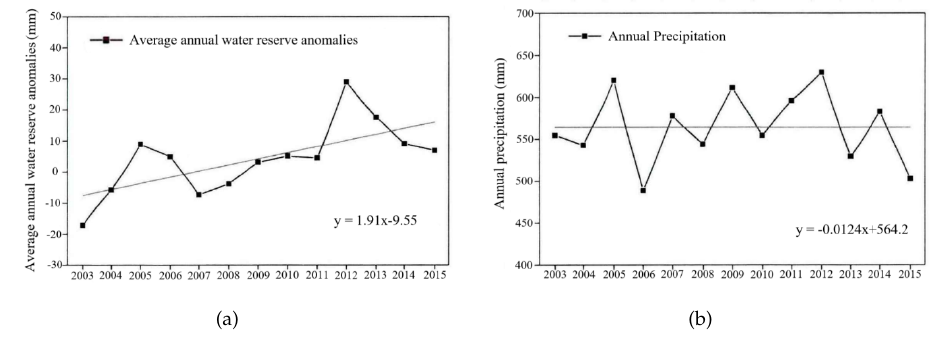
Figure 15. Annual time series of ( a ) terrestrial water storage anomalies; and ( b ) precipitation during the period 2003–2015 across the entire Source Region of the Yellow River